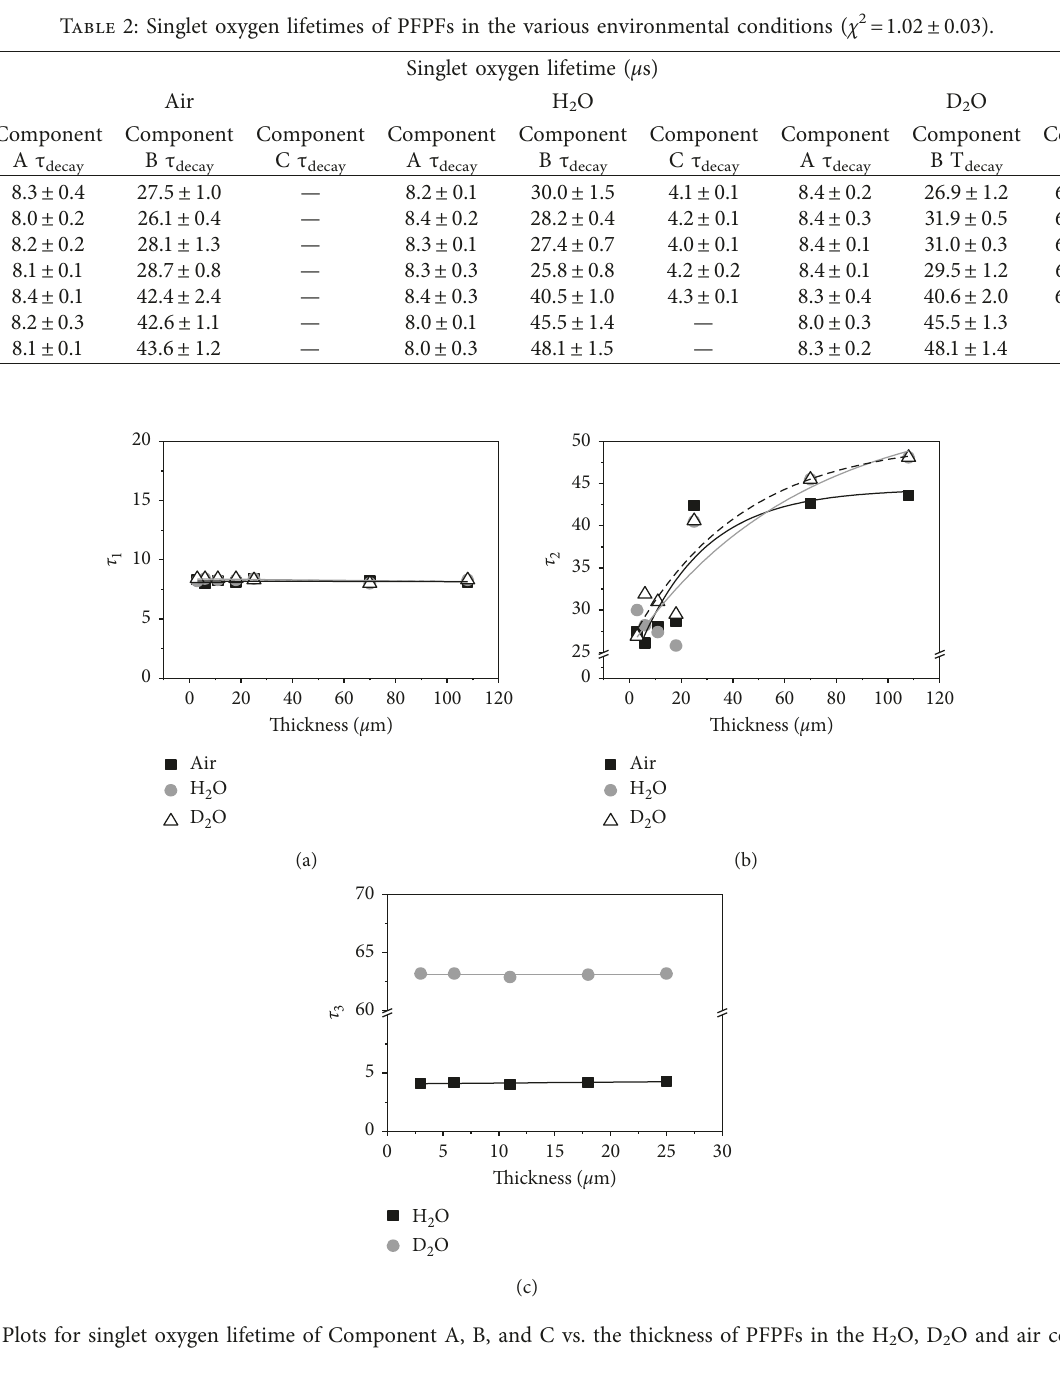
2 O, D 2 O and air conditions.